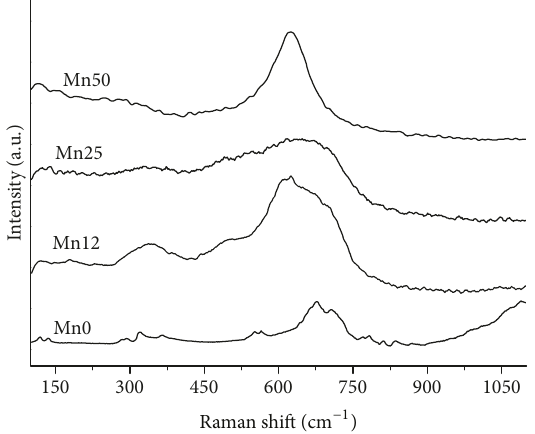
Figure 3: Raman spectra of the samples. Spectra were shifted along the intensity axis to better appreciate the difference in the Raman scattering profiles.